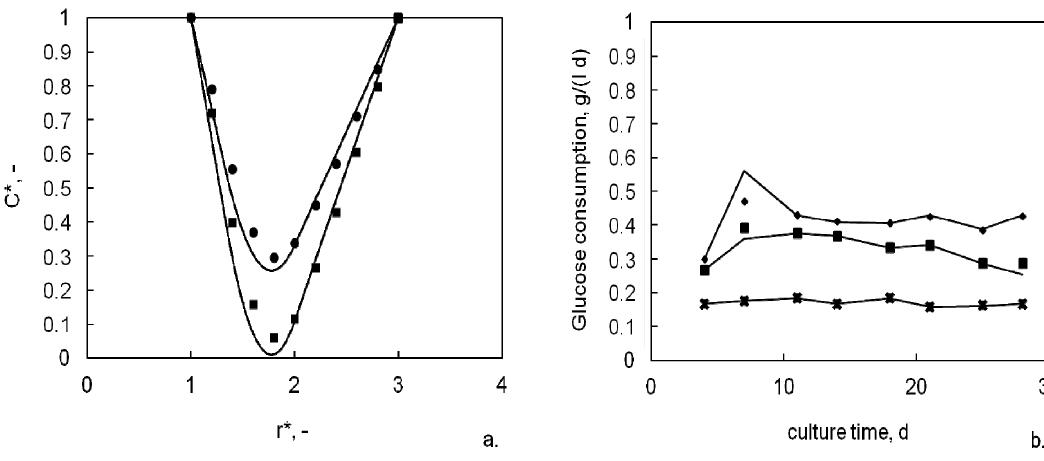
/ δ = 1.49, Pe = 0.67, k L / R i3 = 1.5 × 10 − 2 i C rad ,max